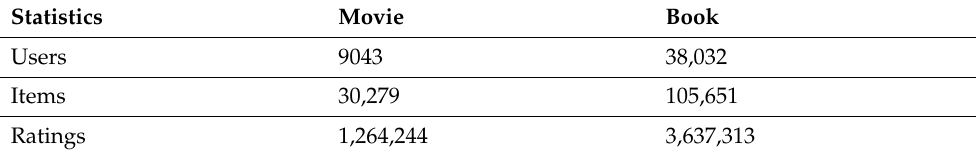
Table 3. Statistics of the Amazon Datasets